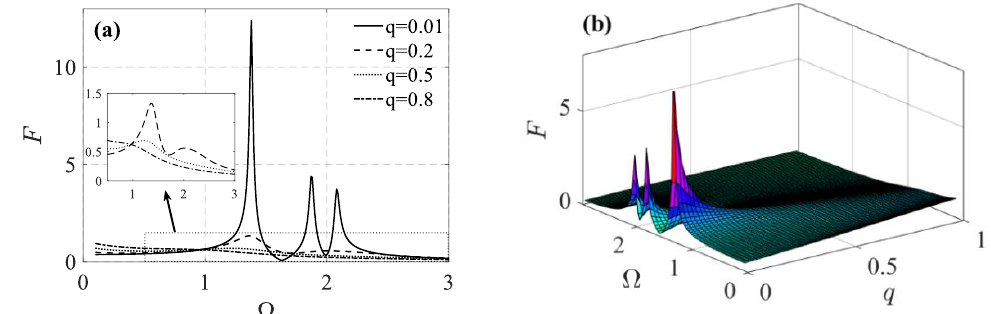
Figure 4. ( a ) Output steady-state amplitude versus excitation frequency with different fractional order under slow switching noise disturbance. ( b ) Dependence of output steady-state amplitude on excitation frequency and fractional damping order.